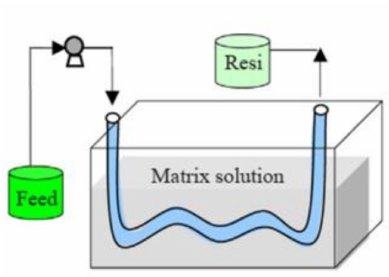
Figure 11. The schematic diagram for the static semi-continuous process using the PVA-based tubular membrane (“Resi” means residual